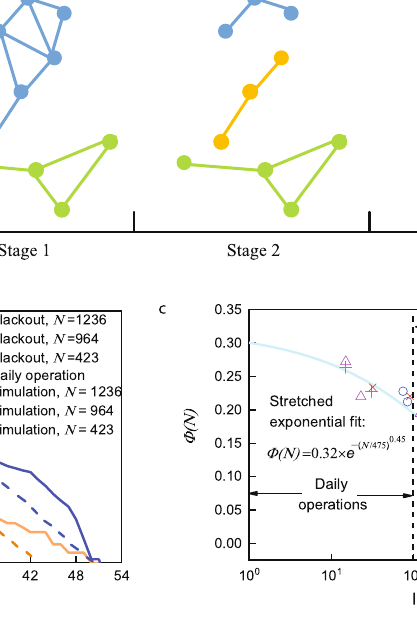
failure dependent links, thus get repaired. b Survival function of outages for three observed blackouts and a month record of daily operation. Exponential distribu- tion can be accepted by all the four curves. During the simulation, the positions of outages are the same as real data. For each blackout, 1000 realizations are simu- lated. c Illustrationofastretchedexponential fi ttotheempiricalfunction ϕ ( N )with respect to the blackout intensity N . Blackouts and daily outage events used for estimation are given in Supplementary Tables S1 and S2,